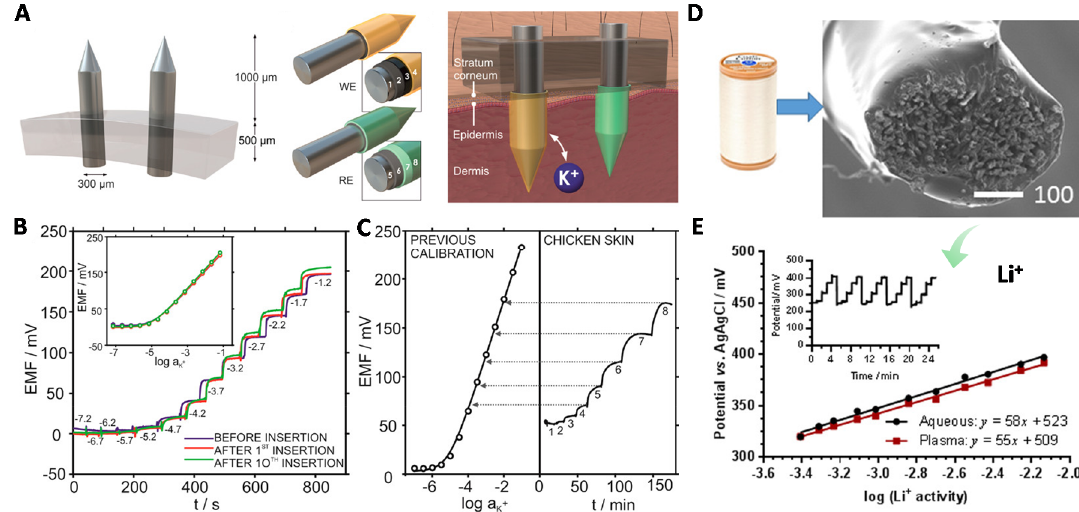
Figure 11. Wearable SC-ISEs for ion detection in interstitial fluid. ( A – C ) Microneedle-based SC-ISEs for K + analysis in skin interstitial fluid. ( A ) Illustration of microneedle patch including working electrode (WE) and reference electrode (RE). For the WE, the bare microneedle was coated carbon, f-MWCNTs and K + -ISM. For the RE, the bare microneedle was coated Ag / AgCl; and poly(vinly butyral) membrane and polyurethane. ( B ) K + response before and after insertion into the animal skin. ( C ) Ex vivo K + measurement in chicken skin with calibration. Reprinted with permission from [88], Copyright (2019) American Chemical Society. ( D , E ) A cotton fiber-based SC-ISEs for Li + sensing in the human plasma. ( D ) A SEM image for the cotton-based SC-ISEs. ( E ) Li + -response in aqueous solution and human plasma. The inset shows the time traces for Li + response. Reprinted with permission from [89], Copyright (2018) American Chemical Society.